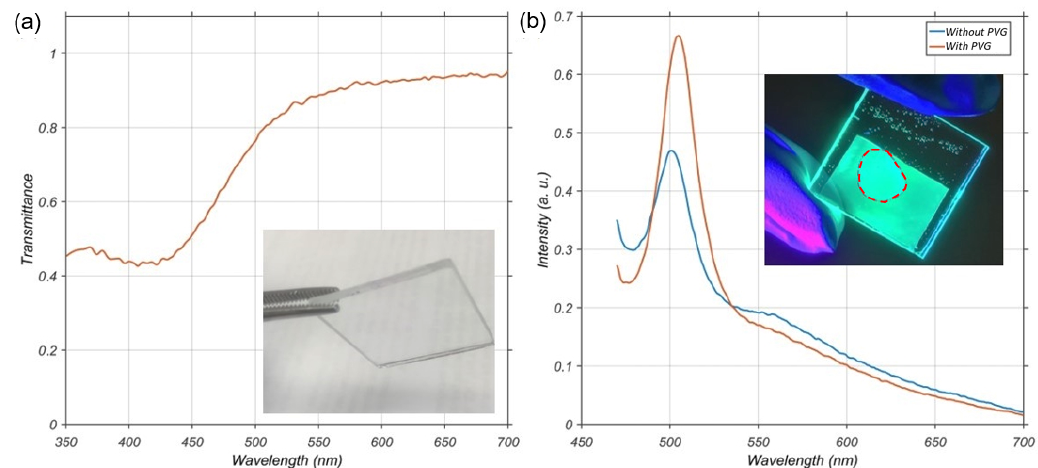
Figure 9. ( a ) Transmittance spectrum of a PVG as the luminance enhancement film. ( b ) Measured PL intensity of a perovskite film with and without the PVG.